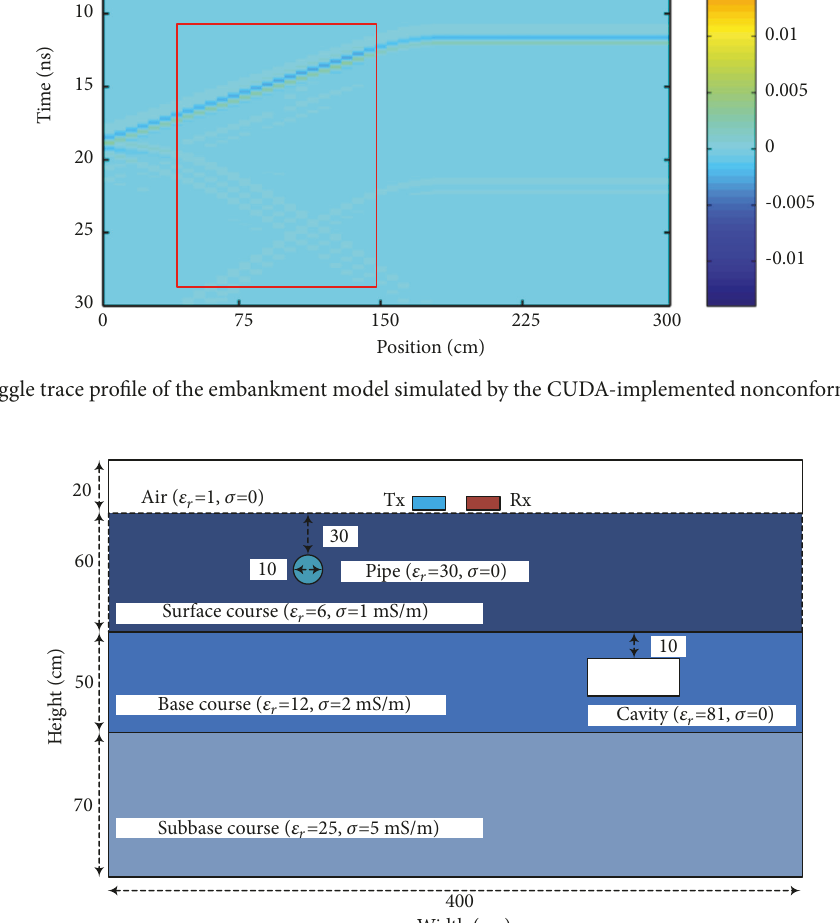
space interval increment and the time step were chosen as Δ𝑥 = Δ𝑦 = 0.5 cm and dt = 0.01 ns,